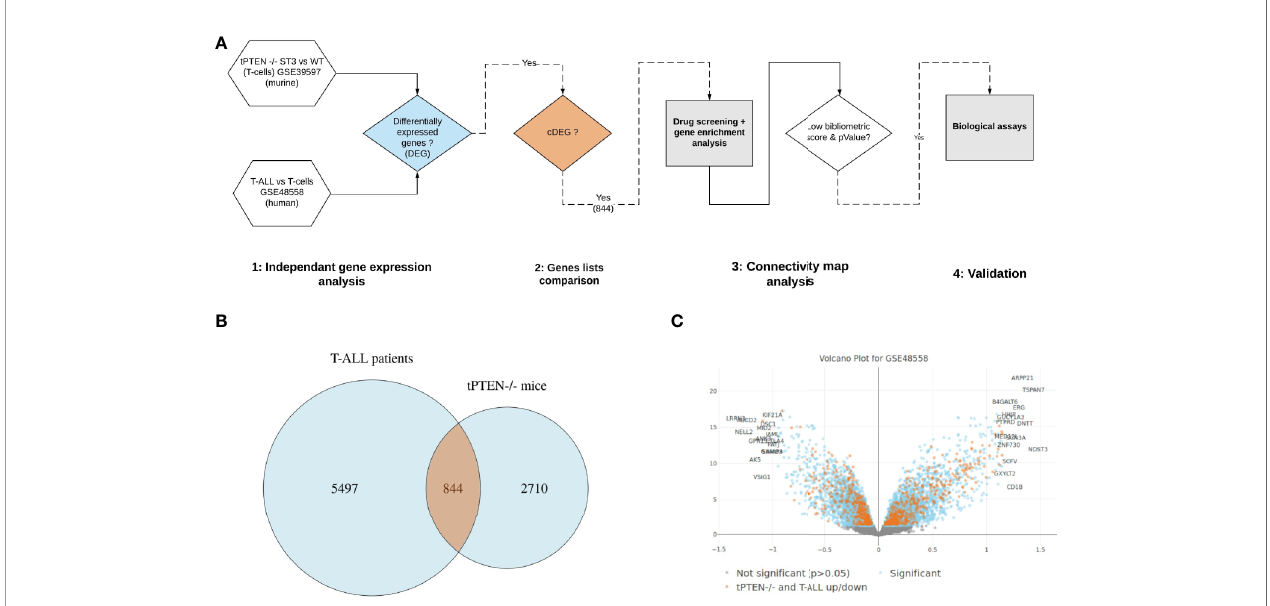
FIGURE 1 | Identi fi cation of common differentially expressed genes in human and murine T-cell Acute Lymphoblastic Leukemia (T-ALL). (A) Bioinformatic analysis pipeline. (B) Differentially expressed genes overlapping between human and mice datasets. (C) volcano plot of human T-ALL dataset (GSE48558). Differentially expressed genes highlighted in orange represent the common core genes, that are similarly regulated (up/down) between mouse and human datasets